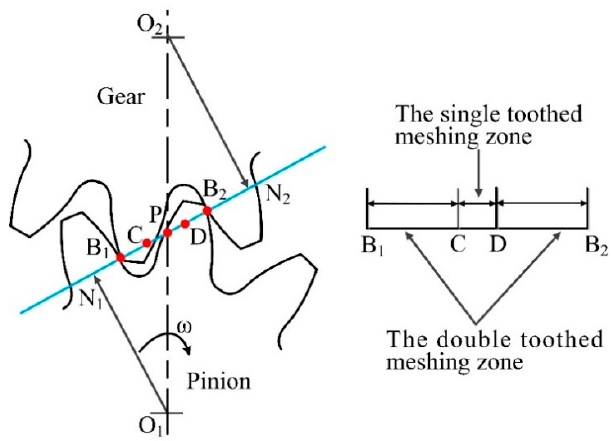
Figure 1. Schematic diagram of gear meshing.